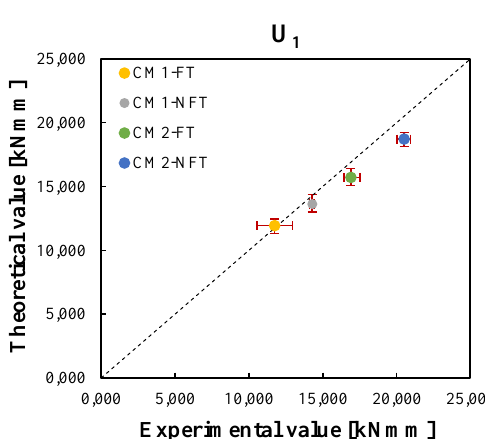
Figure 12. Correlation between the experimental and theoretical average values of the equivalent postcracking strengths after the freeze – thaw cycles, 𝑓 𝑒𝑞(0.6–3),𝑎𝑣𝑔𝐹𝑇 , and before the freeze – thaw cycles of Ref. [42], 𝑓 𝑒𝑞(0.6–3),𝑎𝑣𝑔𝑁𝐹𝑇 , for the CM1 and CM2 mixtures.